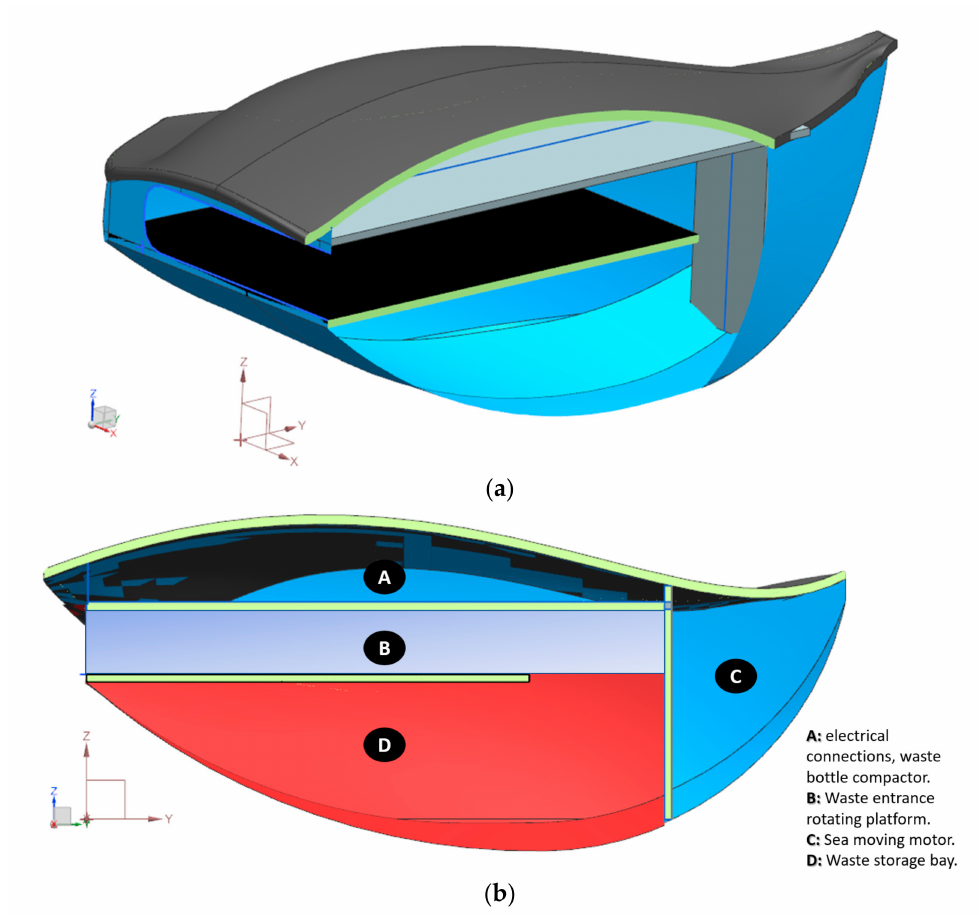
Figure 18. Geometry Validation: ( a ) 3